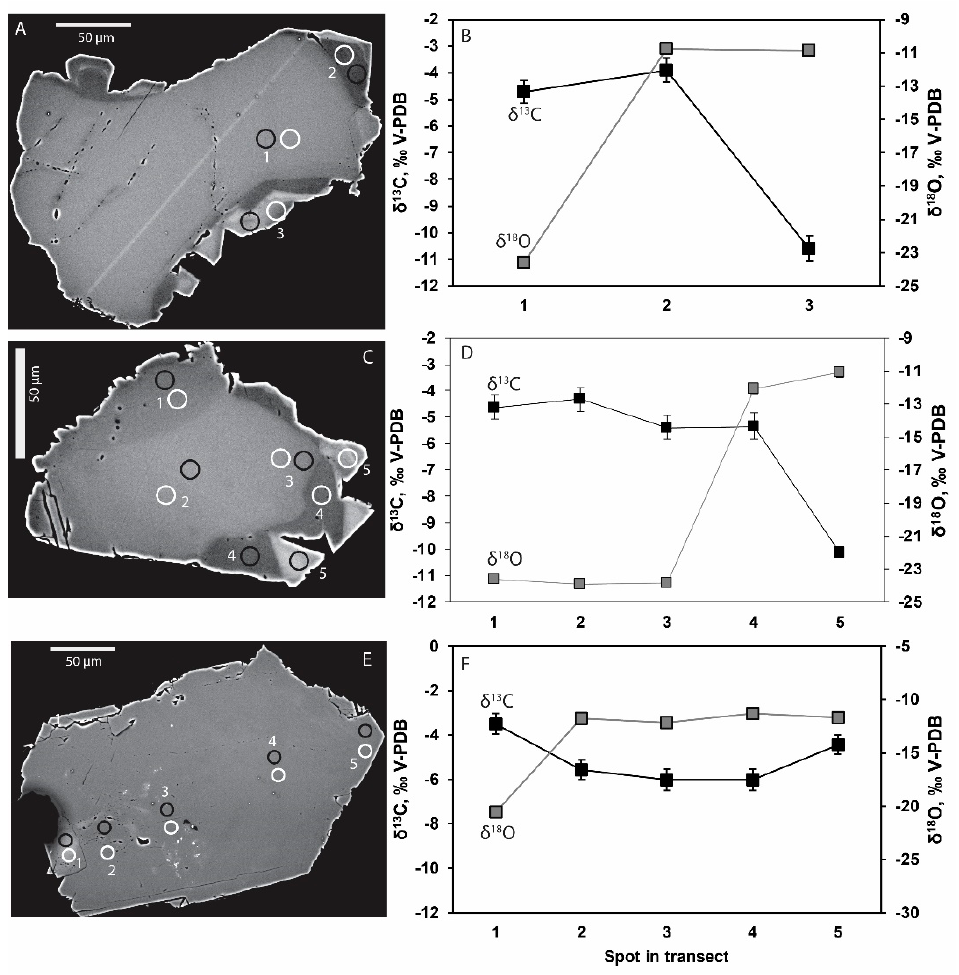
Figure 4. Microanalytical secondary ion mass spectrometry (SIMS) transects within calcite. Back scattered electron images of polished crystal cross sections are shown to the left ( A , C , E ) with spot locations indicated, for closely spaced 10 µ m δ 13 C (black) and δ 18 O (white) SIMS spots. Corresponding isotopic values are shown on the graphs in B (sample 122 m), D (122 m), and F (178 m). Pyrite shows δ 34 S compositions ranging from − 20.5‰ to +20.9‰ V-CDT (span 41.4‰, n spots = 89, n samples = 3). Two samples show very narrow span, vein 1051 m: 7.8‰ ± 1.6‰ and micro-karst 122 m: 18.8‰ ± 2.2‰. The karst sample 178 m shows two distinct groups ( − 19.8‰ ± 1.6‰ and +16.4‰ ± 1.0‰) and one value in between ( − 0.1‰), of which the isotopically heaviest group overlaps with micro-karst sample 122 m. Petrographically, the isotopically heavy pyrite in sample 178 m is oldest,